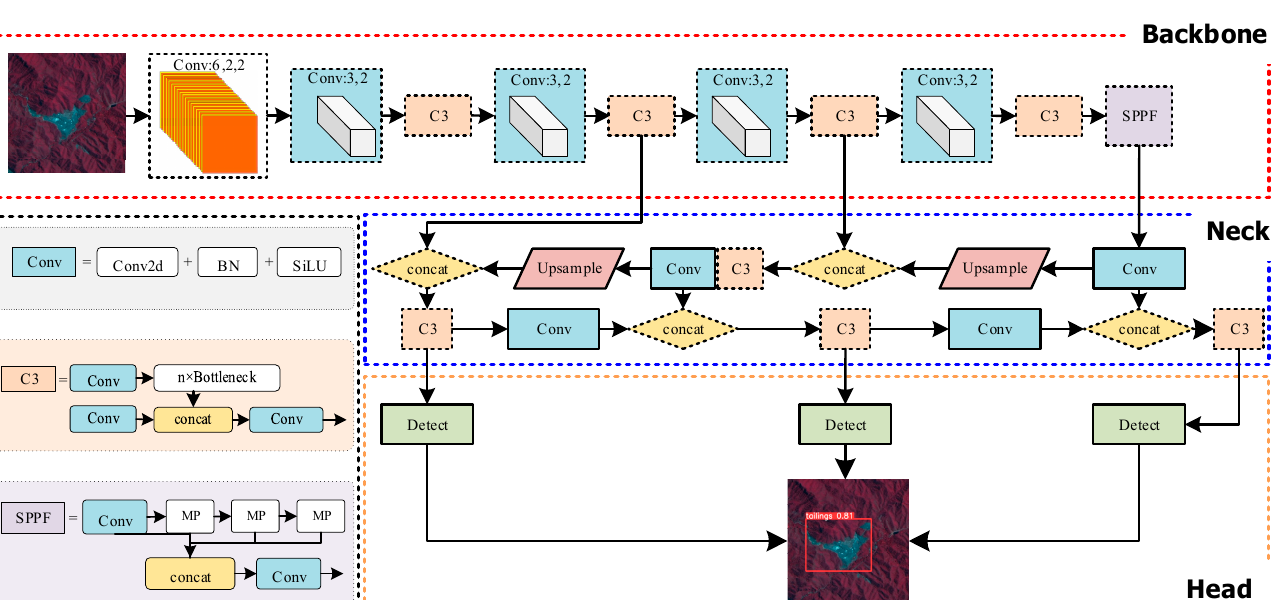
Figure 4. Examples of negative samples in the GF-6 image. ( a ) Water reservoir, ( b ) bare rock, ( c ) bare land, and ( d ) cloud.